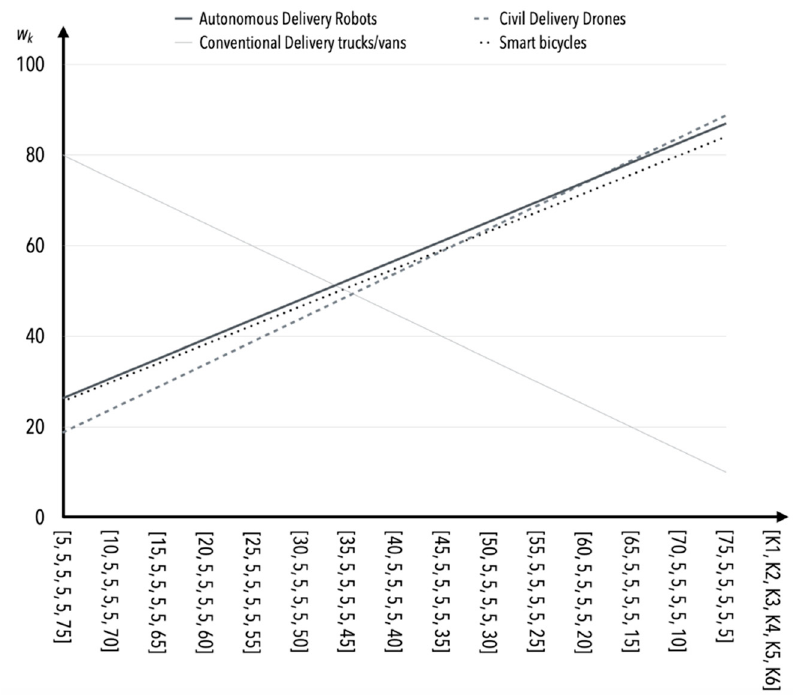
Figure 5. The influence of weight value changes for criterion K 4 on criteria K 1– K 3, K 5 (in the case of S1).